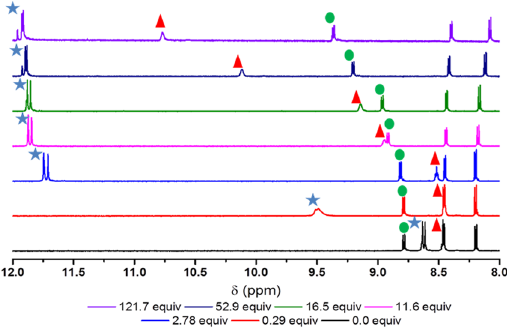
Figure 3. 1 H NMR spectra (600 MHz, 6.24 mM, 293 K) of 4 with increasing amount of tetrabutylammonium acetate added in hydrated DMSO-d6 (0.5% v/v). The blue star indicates the signal arising from the urea N-H protons, the green circle the signal arising for the C5 naphthalimide proton and the red triangle the 4-amino NH proton.